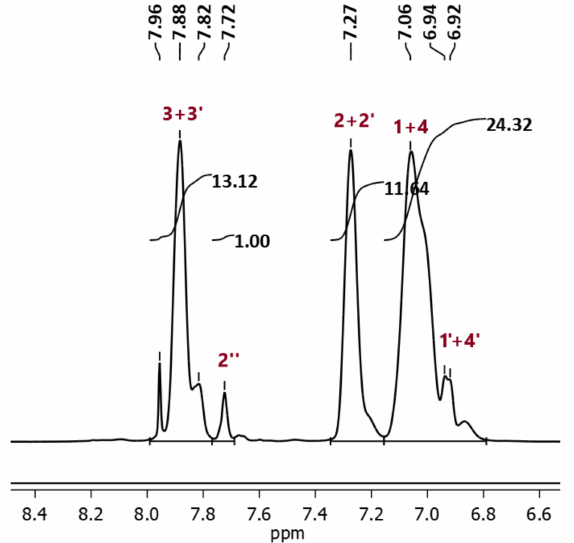
Figure 6. 1 H-NMR pattern of SPSf-8.